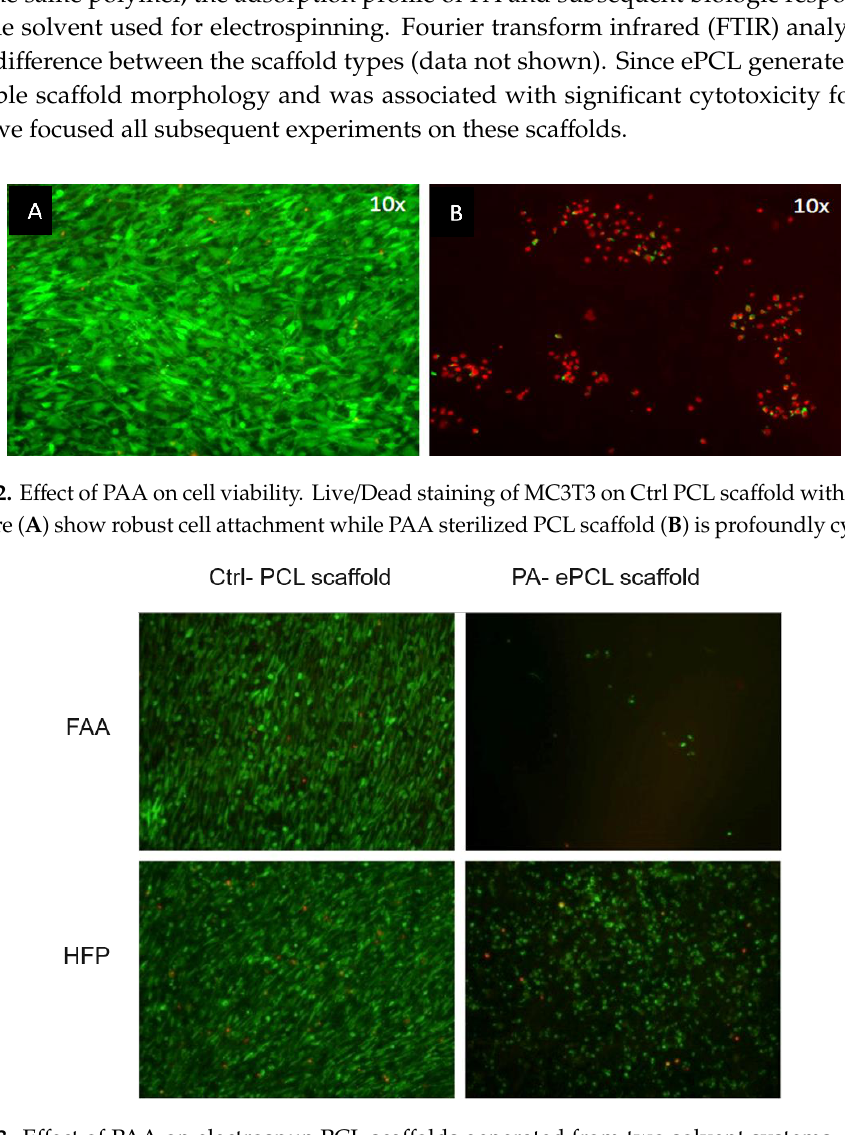
Figure 3. Effect of PAA on electrospun PCL scaffolds generated from two solvent systems. The top panel is PCL electrospun from formic acid: acetic acid while the bottom panel is from HFP. While control scaffolds (with no PAA exposure) show identical cell attachment, exposure of PAA induces a markedly different response. Whereas PAA-ES from formic acid: acetic acid is completely cytotoxic, scaffolds from HFP show moderate cell survival although with altered cell morphology. All images are at 10X magnification.